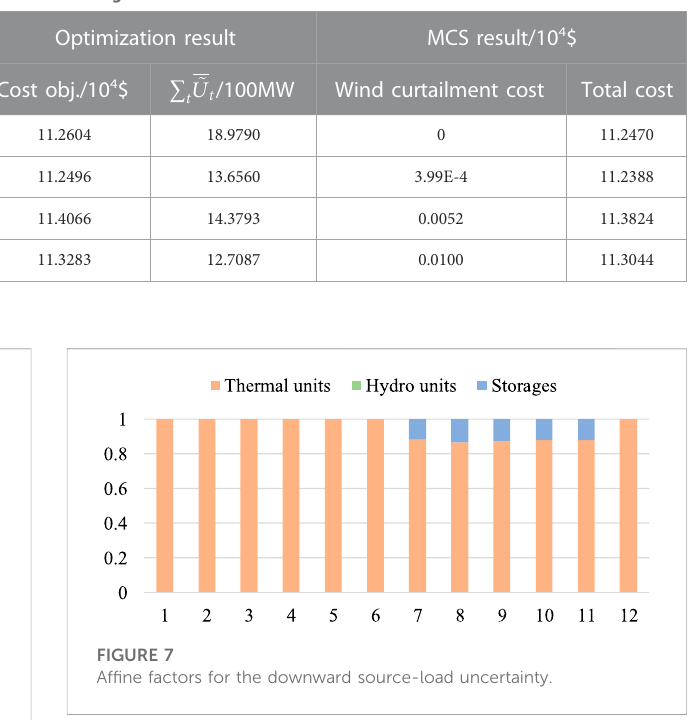
TABLE 1 Optimization and MCS results with different wind power accommodation strategies.